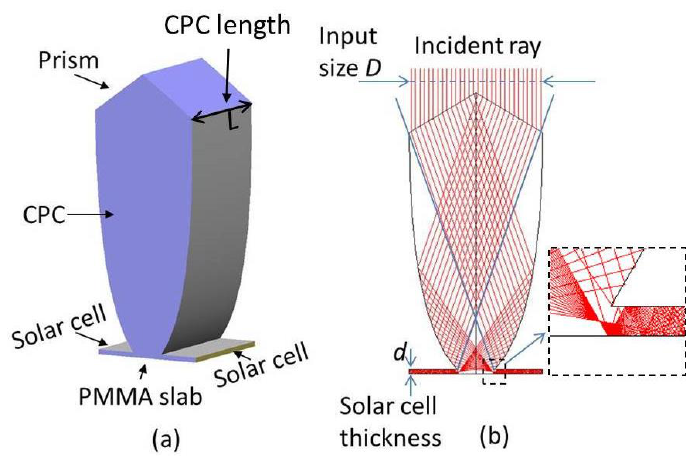
Figure 3. ( a ) Physical layout of P-CPC; and ( b ) mechanism of sunlight concentration by ray tracing.